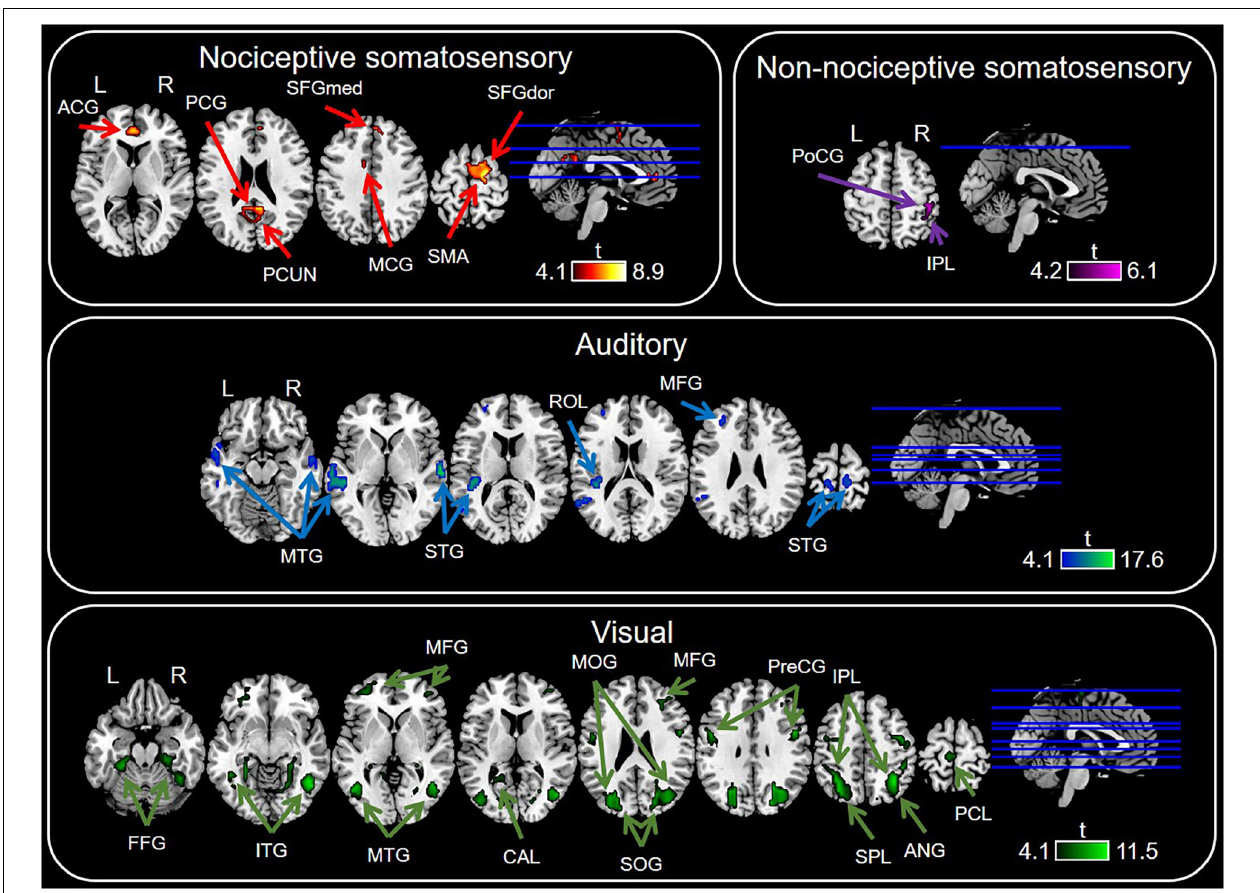
FIGURE 4 | Sensory modality-specific regions defined by conjunction analysis of General Linear Model (GLM) maps. Significant results were identified at P < 0.0001 with FDR correction. ACG, anterior cingulate gyrus; ANG, angular gyrus; CAL, calcarine sulcus; MCG, middle cingulate gyrus; FFG, fusiform gyrus; IPL, inferior parietal lobule; ITG, inferior temporal gyrus; MFG, middle frontal gyrus; MOG, middle occipital gyrus; MTG, middle temporal gyrus; PCG, posterior cingulate gyrus; PCL, paracentral lobule; PCUN, precuneus; PoCG, postcentral gyrus; ROL, rolandic operculum; PreCG, precentral gyrus; SFGdor, dorsolateral part of superior frontal gyrus; SFGmed, medial part of superior frontal gyrus; SMA, supramarginal gyrus; SOG, superior occipital gyrus; SPL, superior parietal lobule; STG, superior temporal